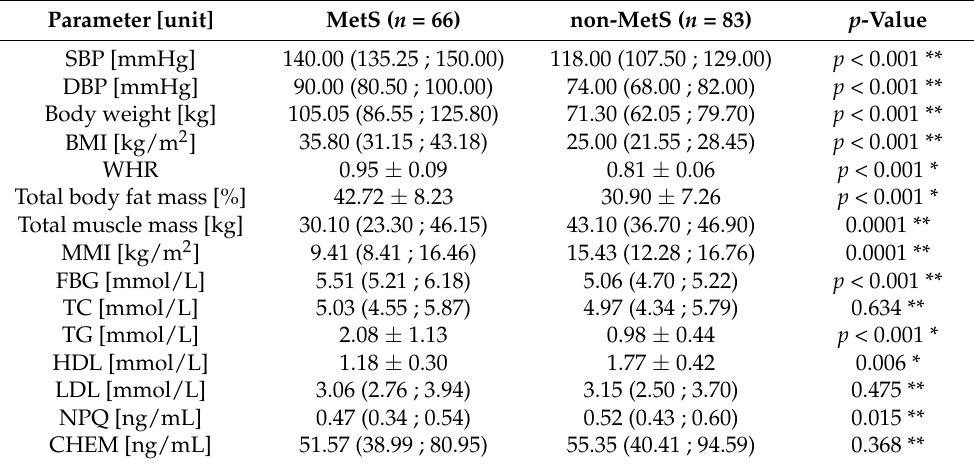
Table 1. Blood pressure and anthropometric and biochemical characteristics of participants, by presence of metabolic syndrome. Parameter [unit] MetS ( n =